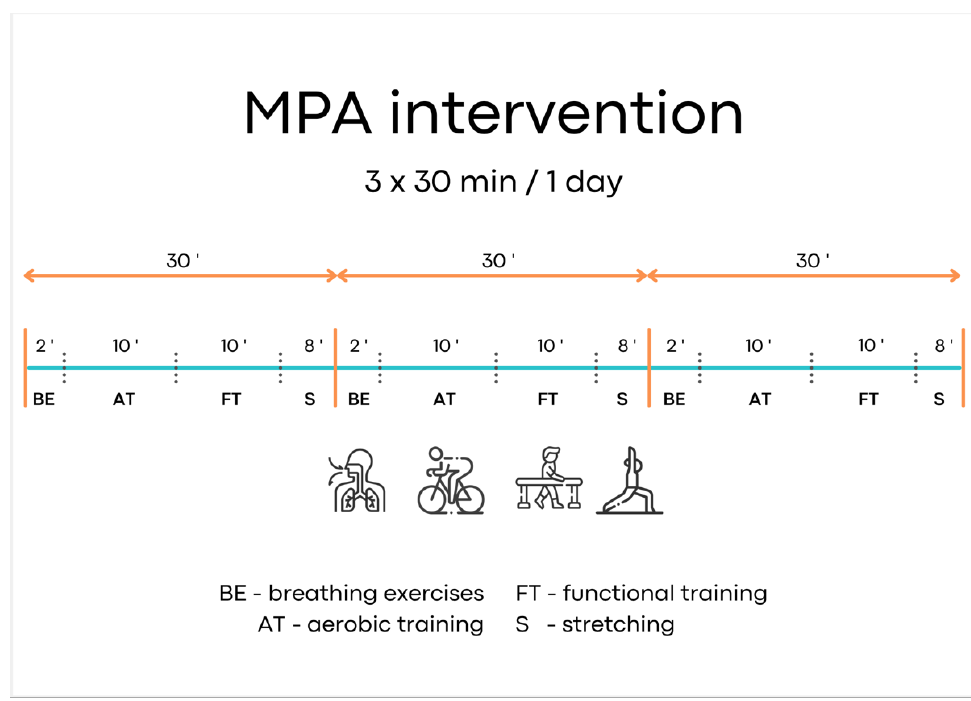
Figure 2. MPA intervention per day.